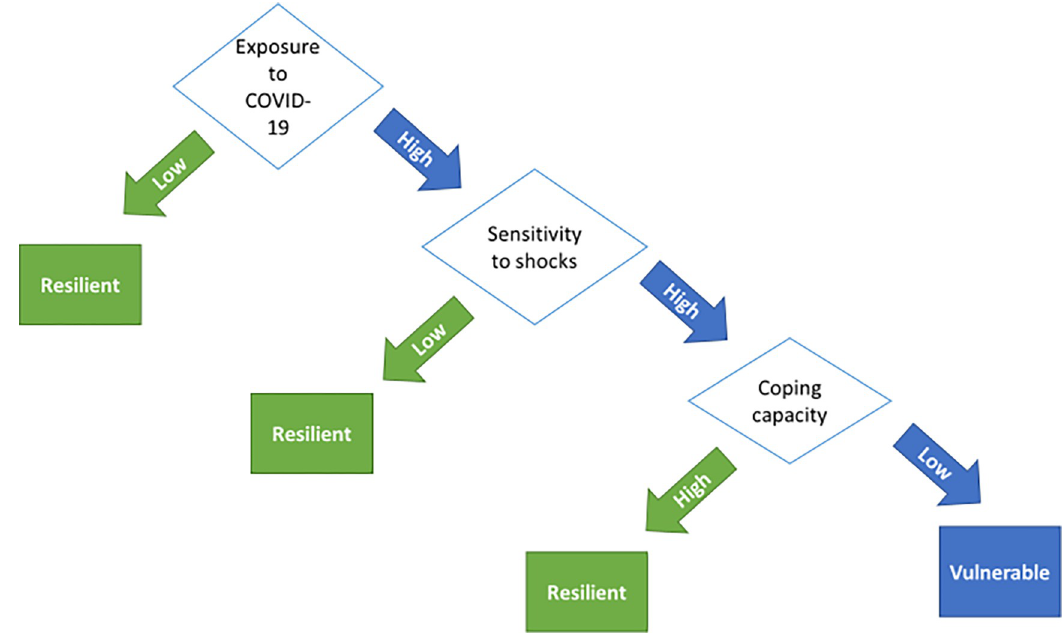
Fig 1. Conceptual framework for determinants of vulnerability and resilience during or following a shock [17].